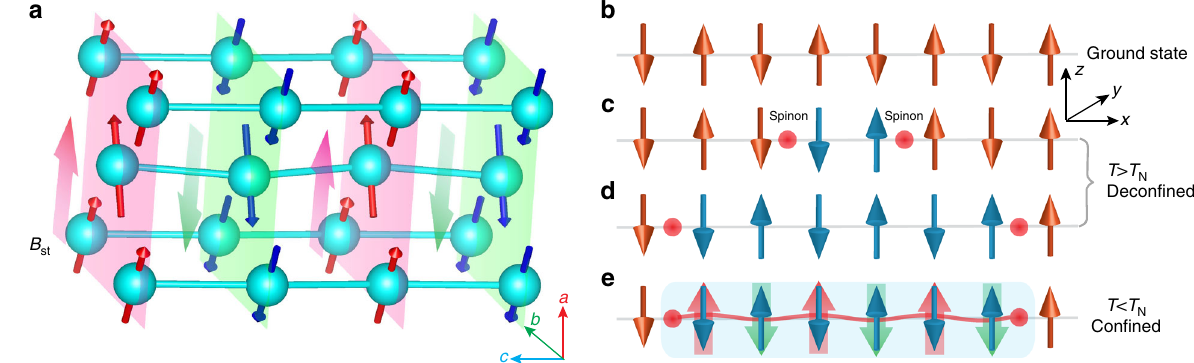
Fig. 2 Illustration of the magnetic structure and spinon con fi nement in YbAlO 3 . a Magnetic structure below T N = 0.88 K, where the Yb Ising moments align antiferromagnetically (AFM) in chains along the c -axis. These one-dimensional (1D) chains are ferromagnetically (FM) coupled in ab -plane, which results in a net staggered fi eld ( B st ), as indicated by the large red and blue arrows. b – e Sketch of the spinon generation and con fi nement in a 1D AFM chain. Since only longitudinal fl uctuations of Δ S z = 0 are observed in YbAlO 3 , even numbers of Yb moments are fl ipped in the AF ground state ( b ), creating pairs of spinons ( c ). These spinons can propagate freely (decon fi ned) along the chain at T > T N ( c , d ), while in the presence of the effective staggered fi eld at T < T fi ned) as the separation increases ( N , propagation of the spinons costs energy (con